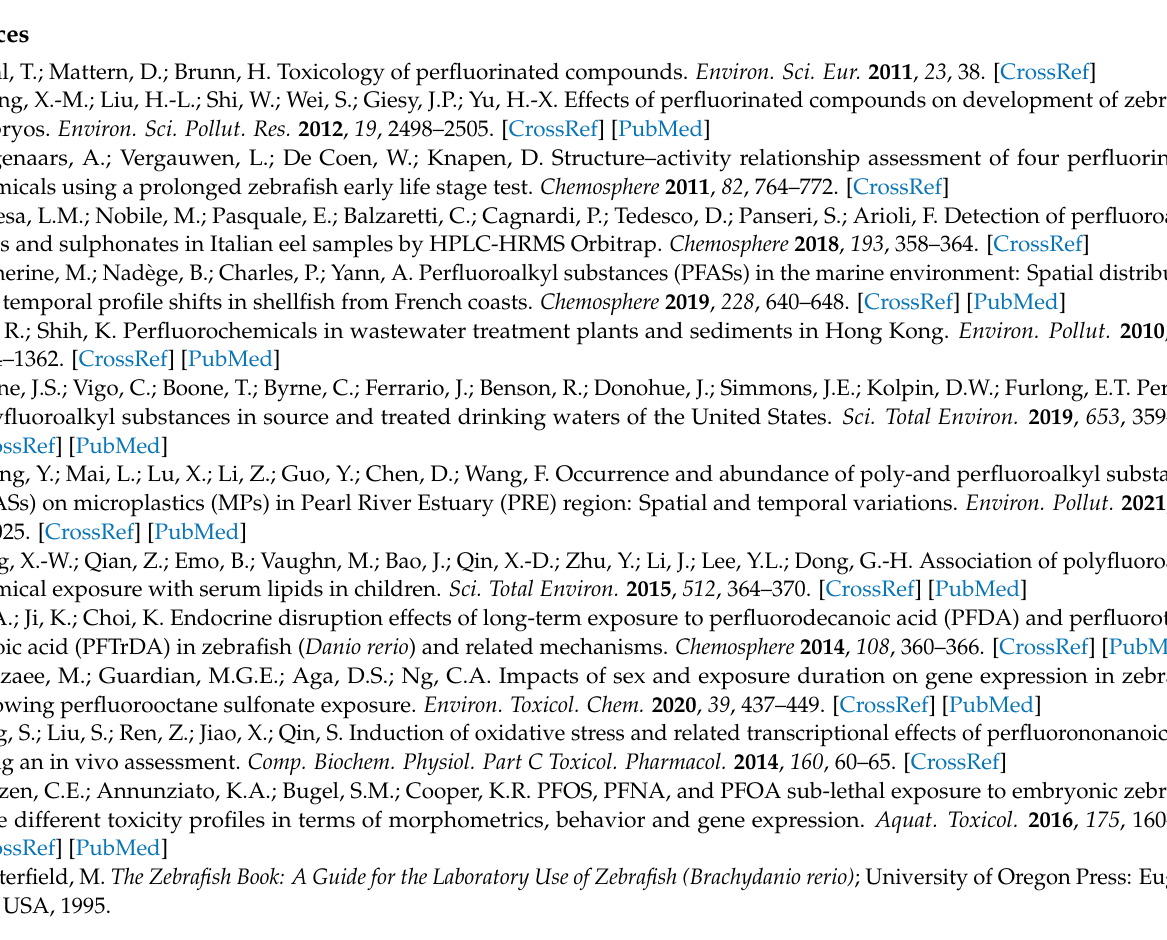
mental Figure S1. The activity of 7-day zebrafish larvae exposed to ERM, 0.1% DMSO, or different concentrations of PFTeDA (0.01, 0.1, 1, or 10 µ M). Supplemental Table S1. Primers used in